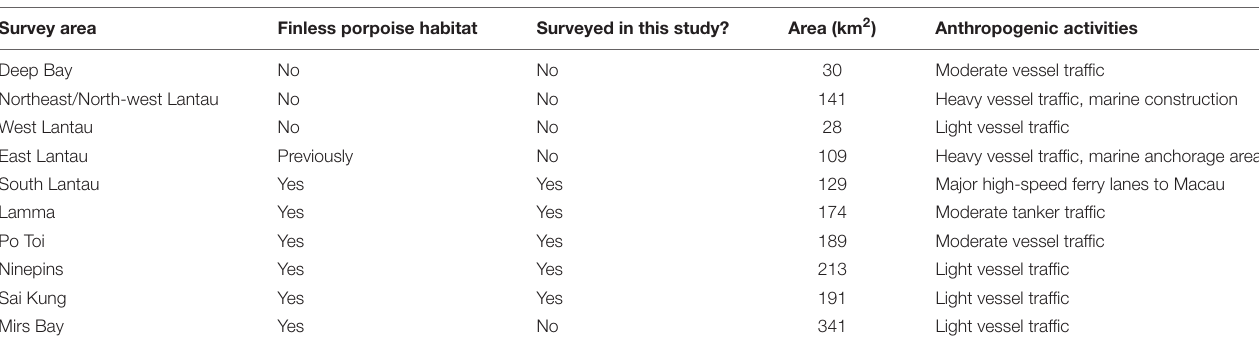
FIGURE 2 | Strandings of finless porpoises in Hong Kong, by year of study (1996–2019). The line was fit by linear regression. TABLE 1 | Summary of all survey strata in Hong Kong and their